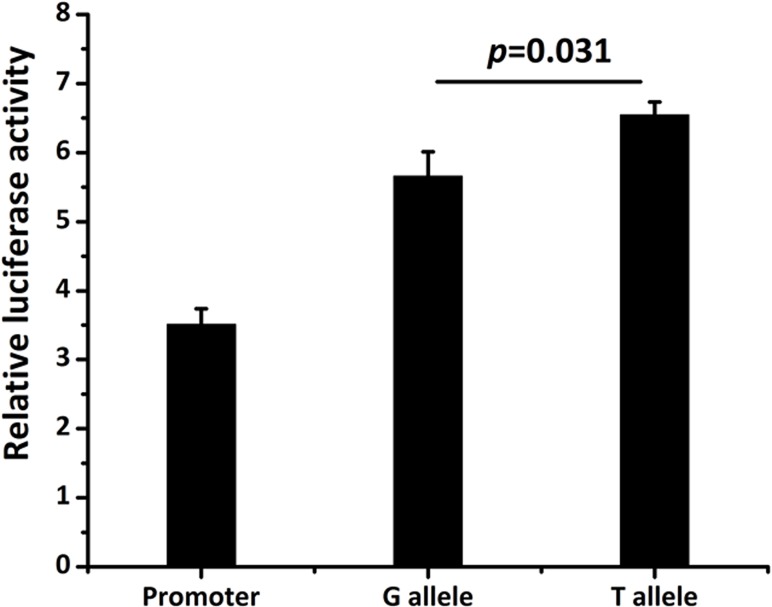
Effects of the promoter Polymorphism (rs17222919, −1316T/G) of ALOX5AP gene on transcriptional activity.The transcription activity was measured using an in vitro luciferase assay and the results were shown as the means ± SE values. Data were expressed as the fold-increase in luciferase activity relative to pGL3- promoter. A one-way ANOVA was used to assess statistical significance.